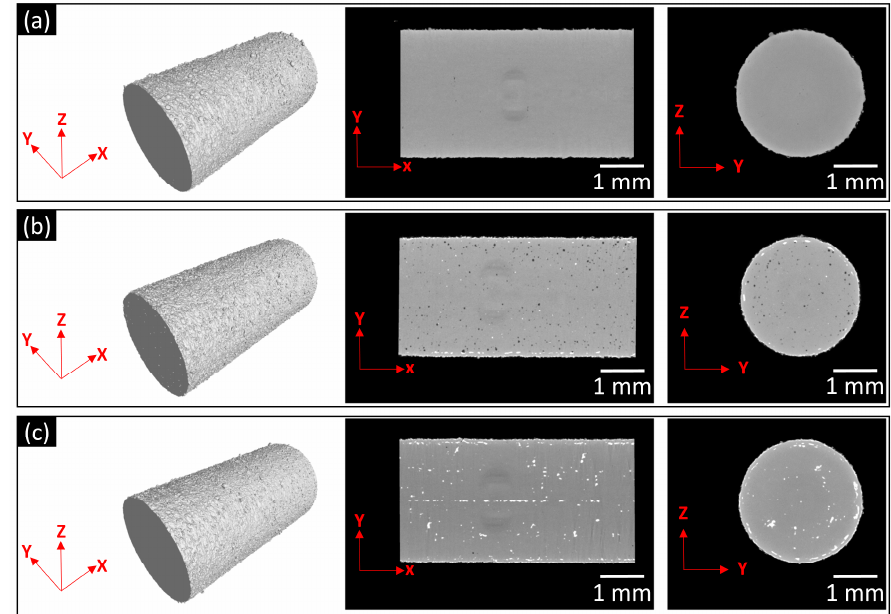
Figure 2. XCT images for: ( a ) an unreinforced 316L specimen synthesized by SLM with a scanning speed of 688 mm/s, ( b ) a 316L/CeO 2 composite synthesized at 350 mm/s, and ( c ) a 316L/CeO 2 composite synthesized at 488 mm/s. Note that the other processing parameters have been kept constant. The small bright particles in ( b ) and ( c ) are CeO 2 and the black dots in ( b ) are porosity.